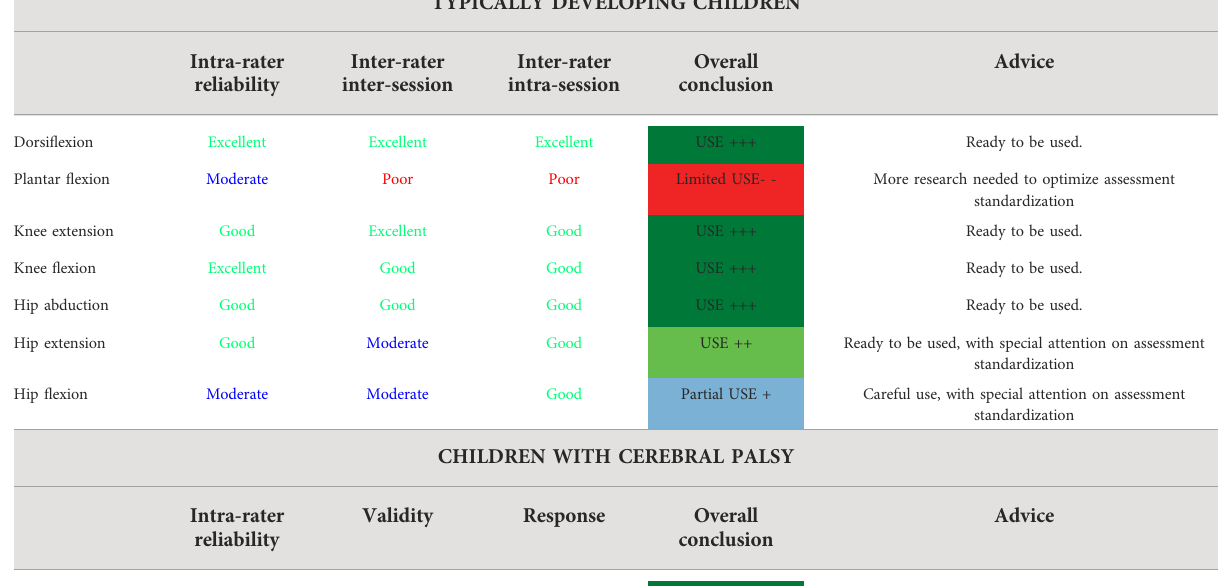
TABLE 7Overview and overall conclusion of the clinimetric properties of the instrumented strength assessment in Typically developing childrenand children with cerebral palsy and Duchenne muscular